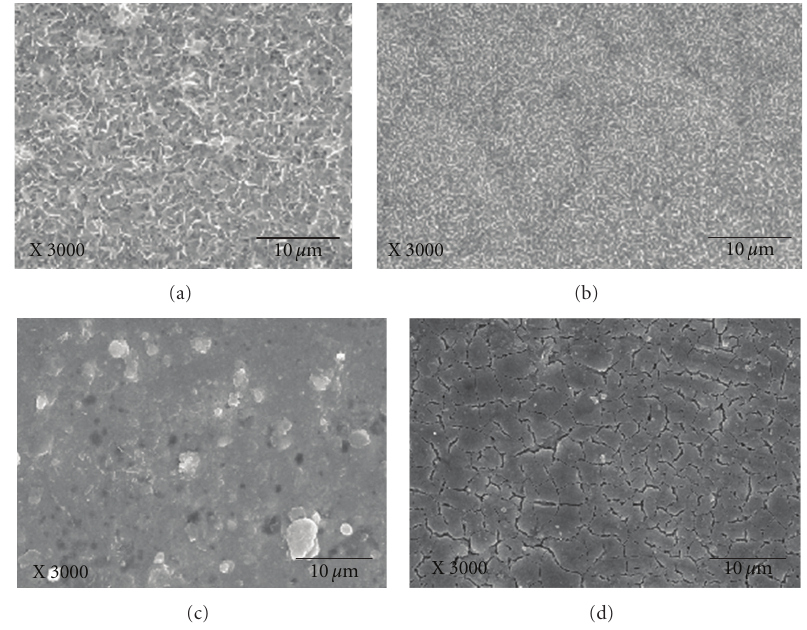
Figure 4: SEM photomicrographs of Basic bath (BB) (a), BB + CTAB (b), optimized bath (c), passivated bath (d).